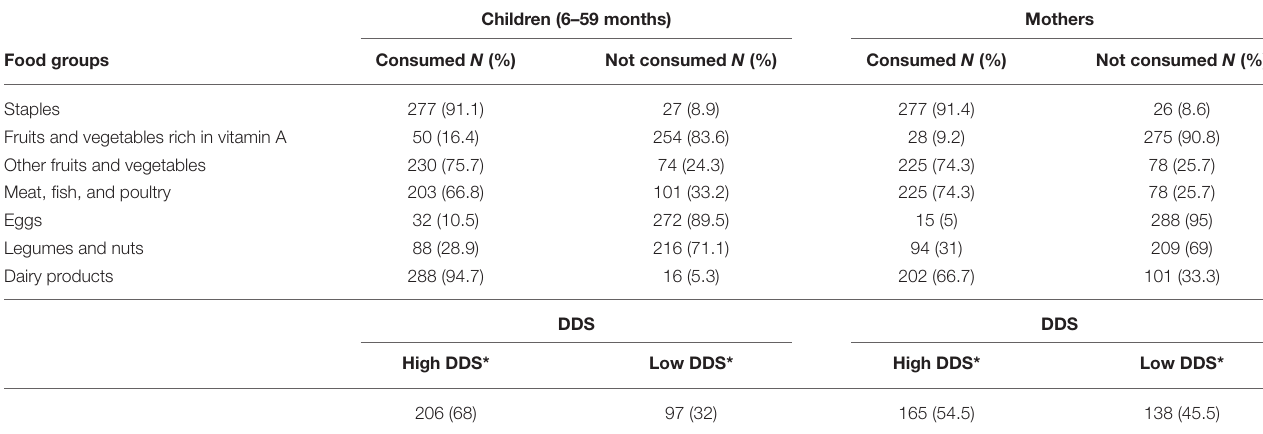
TABLE 3 | Frequency of a food group’s consumption and dietary diversity score of mothers and